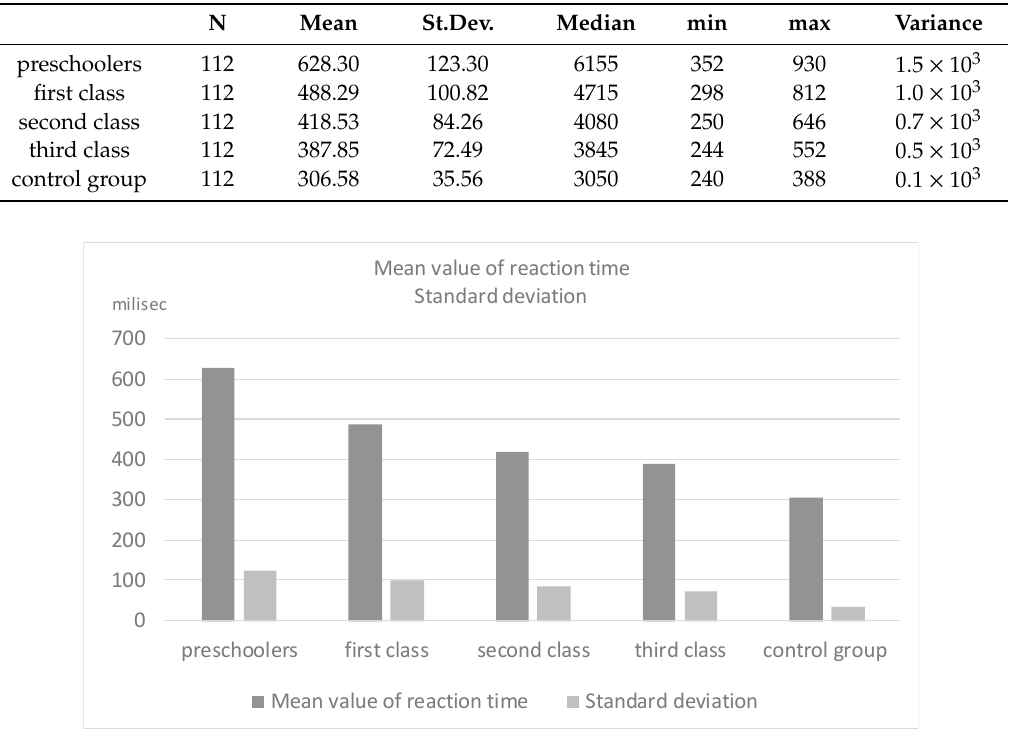
Figure 1. Descriptive Statistics.